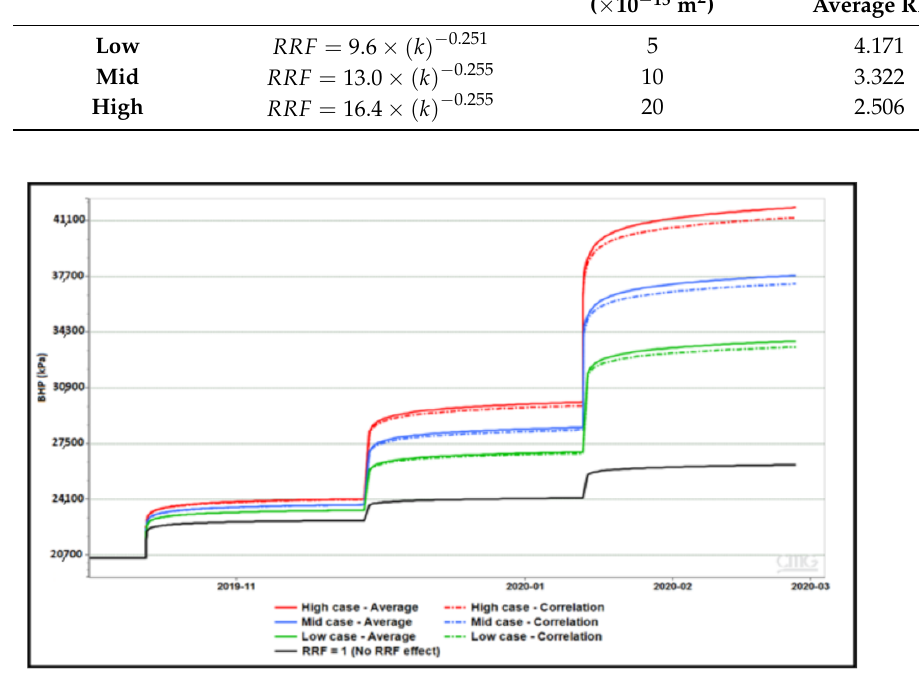
Figure 13. Impact of RRF correlations and averages on concentration